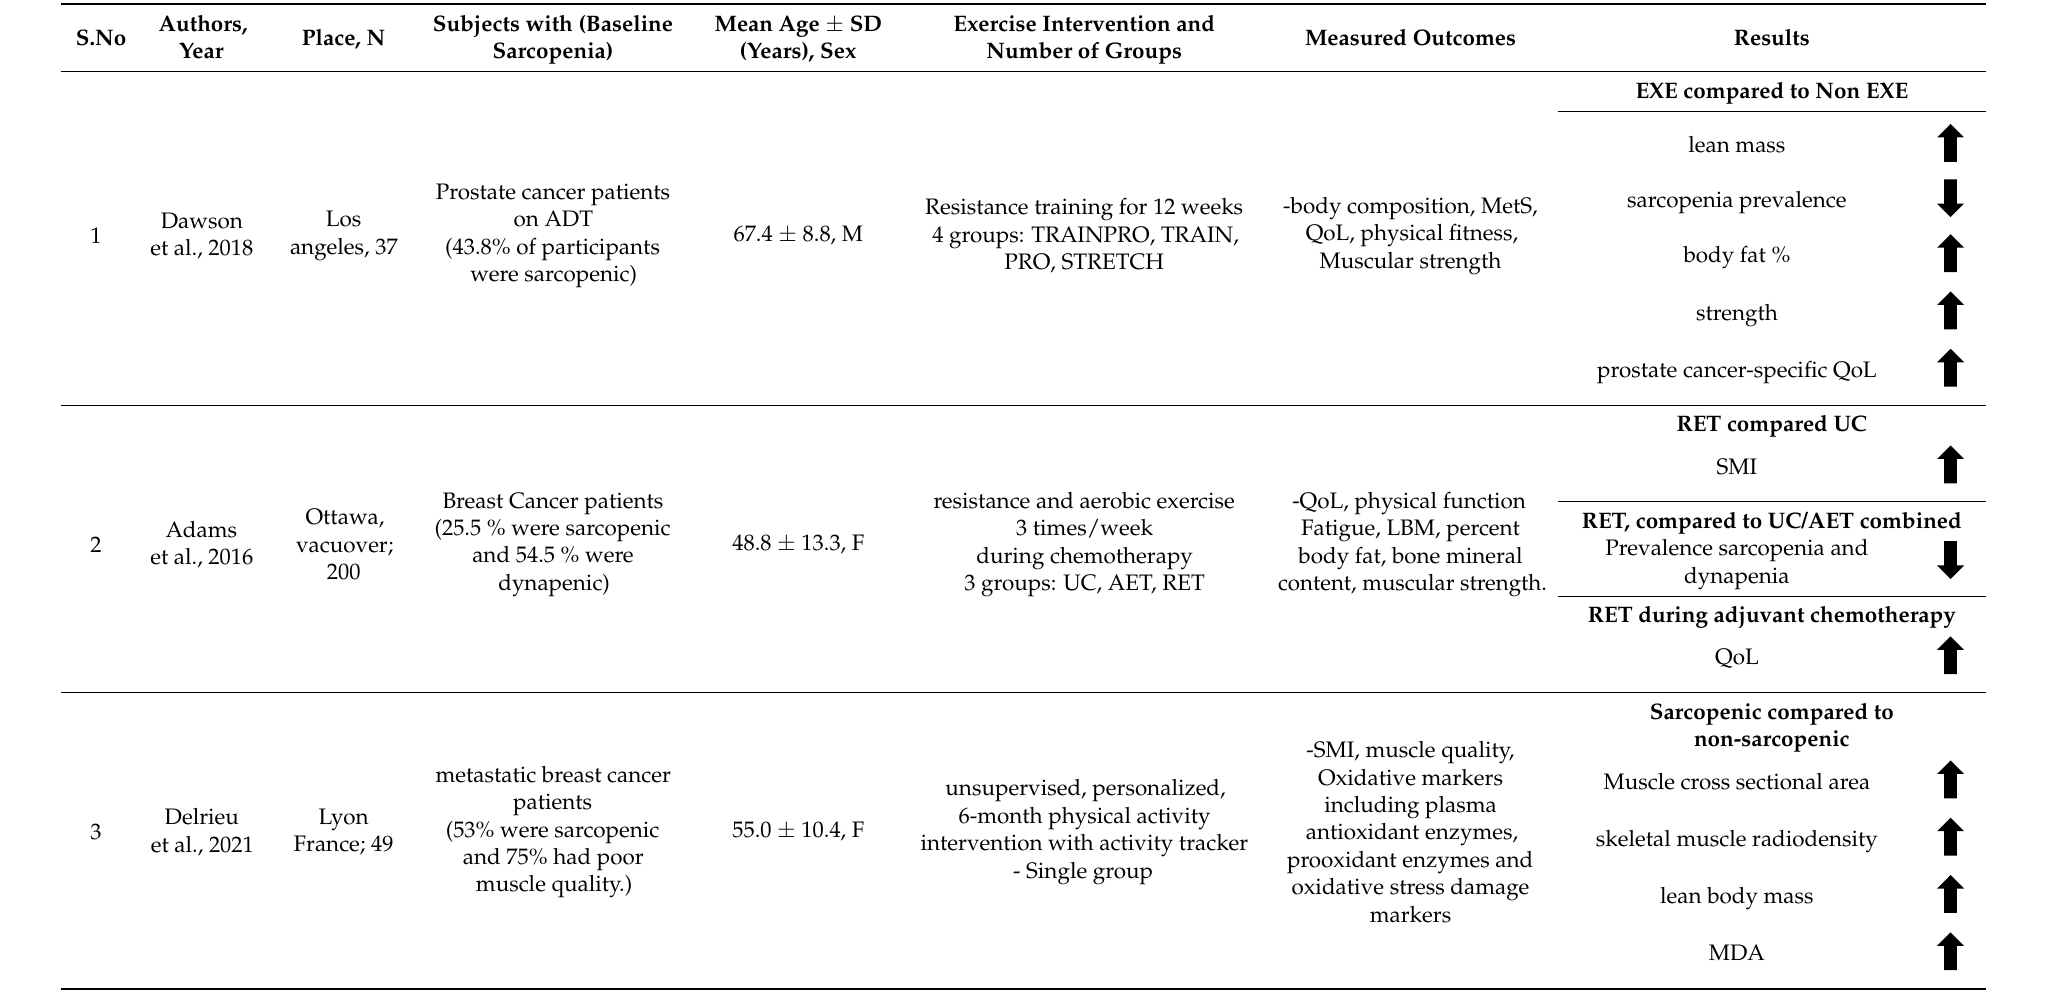
Table 1. Effect of exercise on subjects with cancer and baseline measurement of sarcopenia.